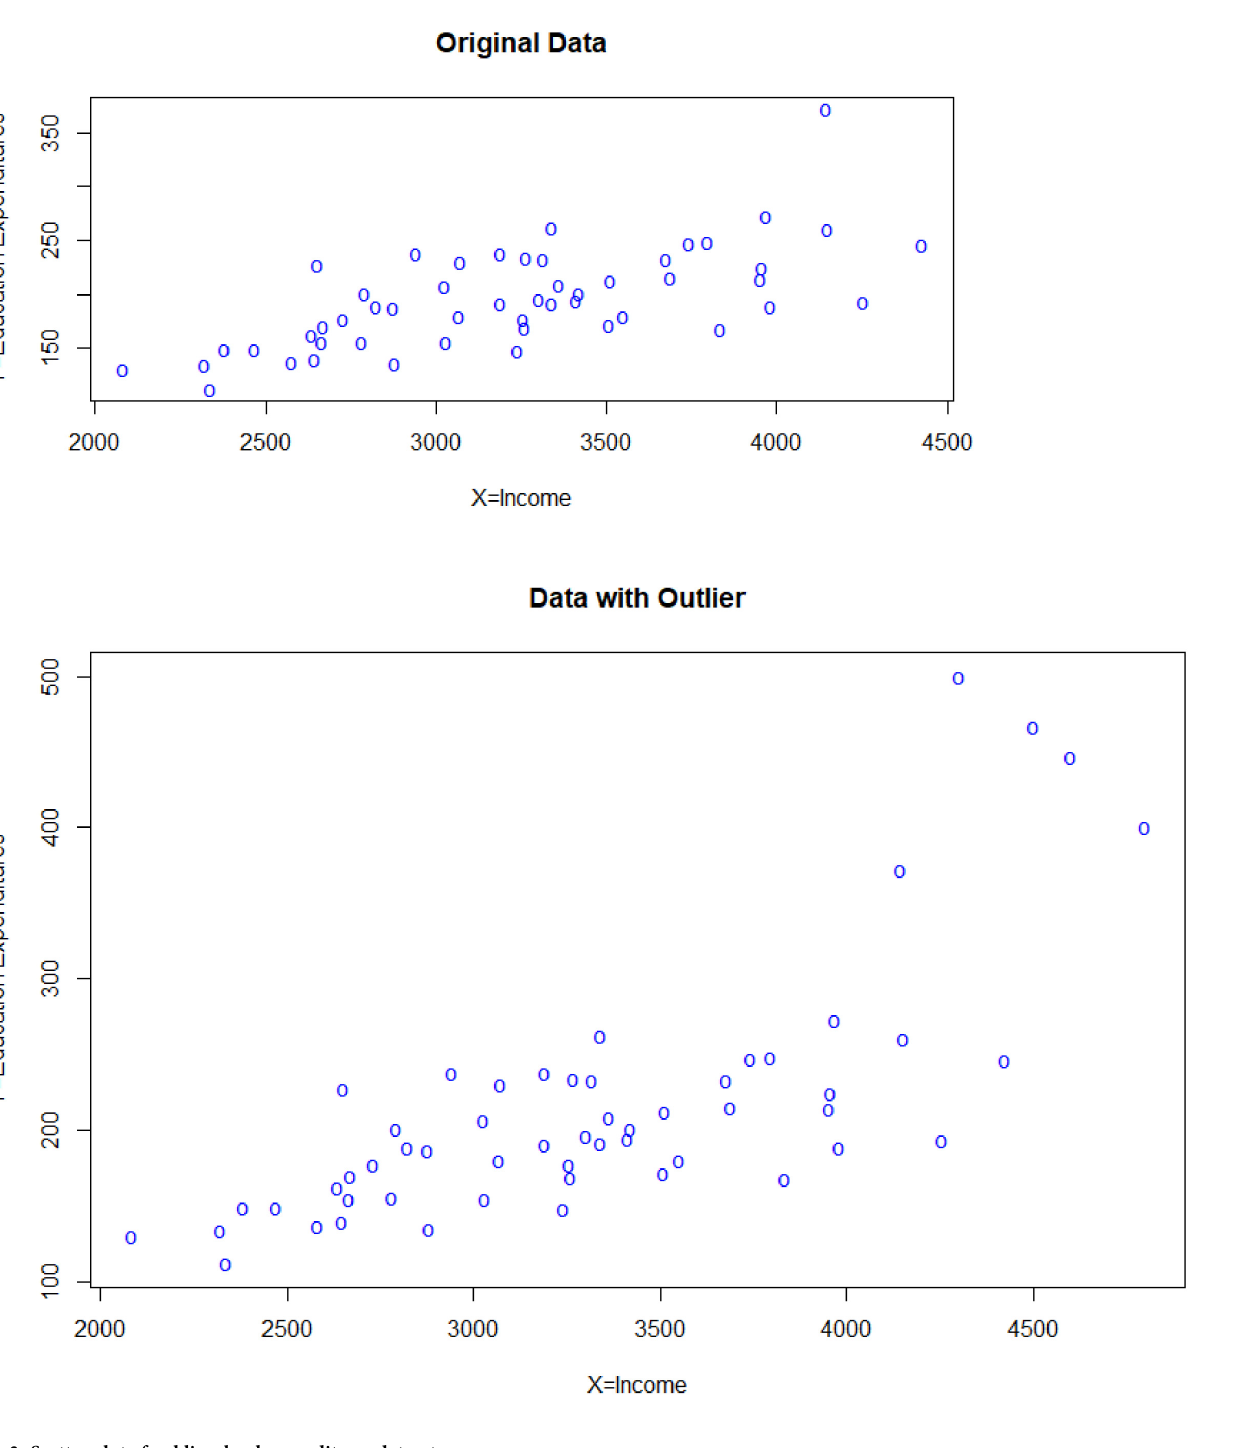
PLOS ONE | https://doi.org/10.1371/journal.pone.0278868 December12,